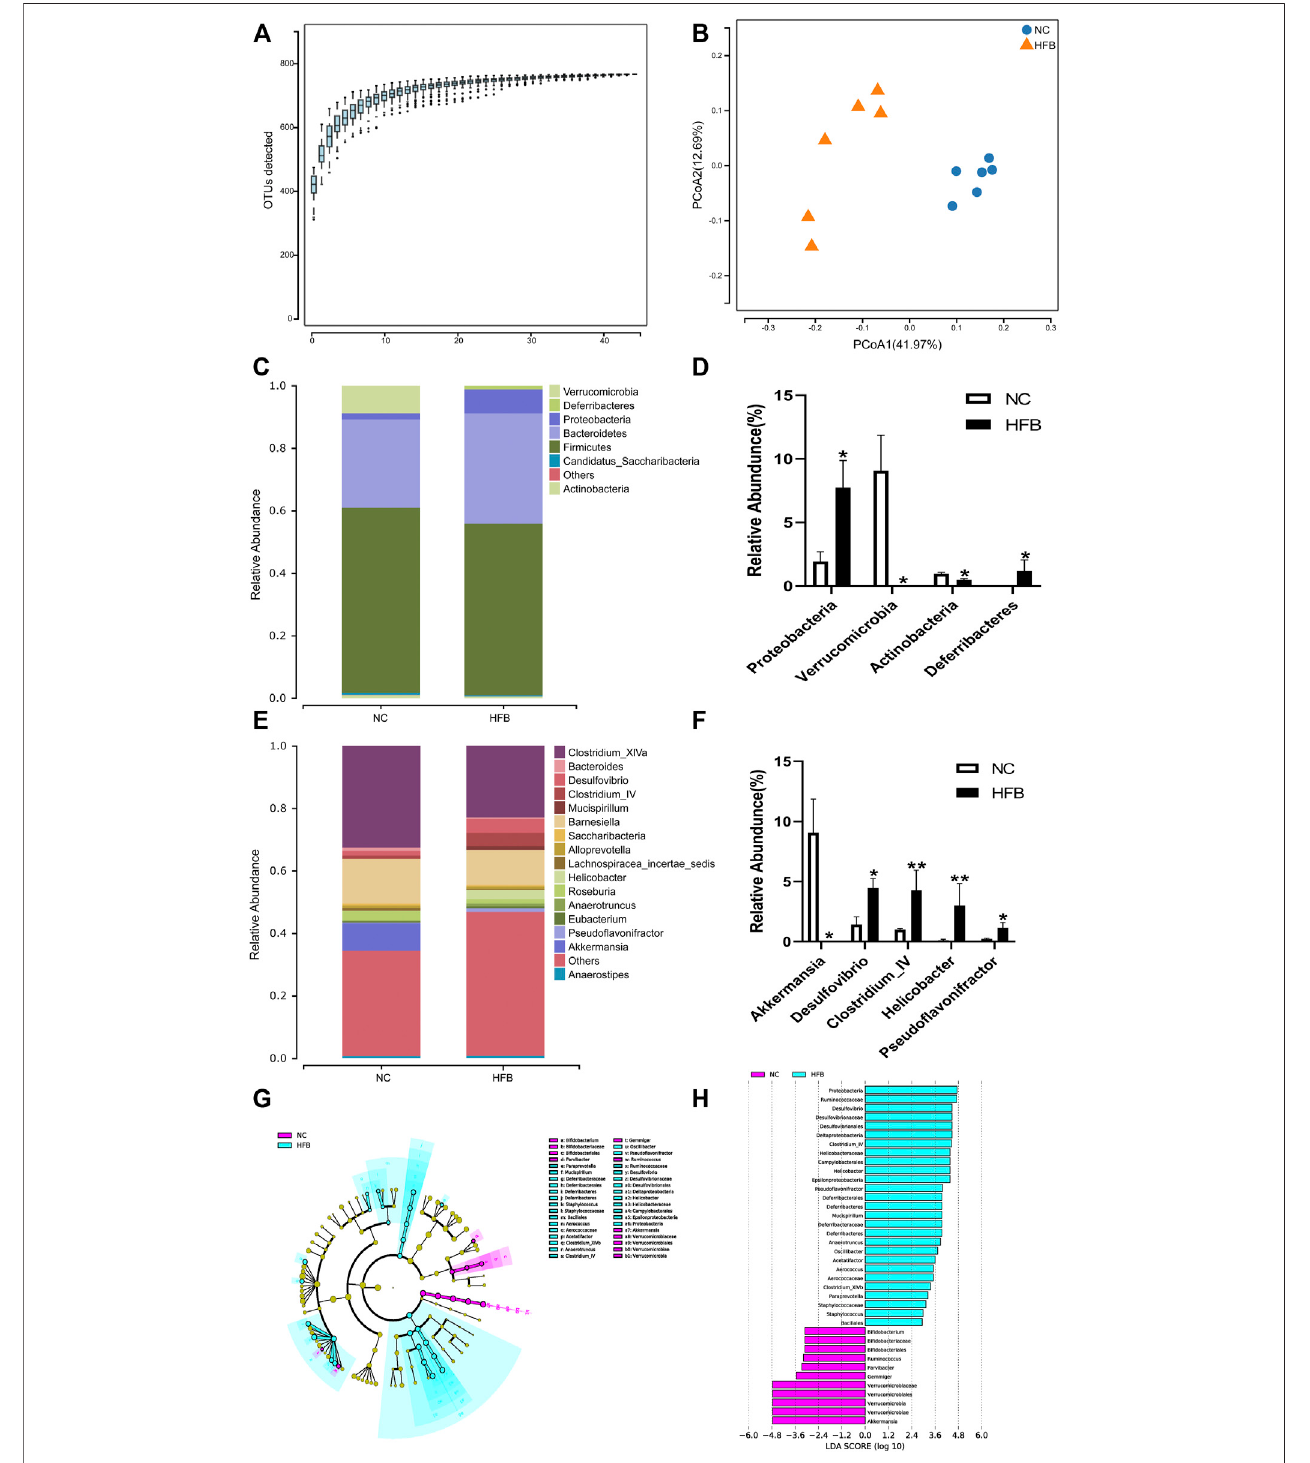
FIGURE 5 | Changes in intestinal fl ora in ApoE − / − mice fed continuous high-fat combined with bound stimulation. (A) Species accumulation graph. (B) PCoA plot. (C,E) Histograms ofspecies composition[ (C) phylum level; E :genus level]. (D,F) Statistical plots ofdifferential species (D) phylum level; (F) genus level),mean ± SEM,*, p < 0.05; **, p < 0.01; vs. NC. (G) LEfSe clustering diagram, with different colors indicating different groups, and different colored nodes indicating microbial groups that playanimportantroleinthegrouprepresentedbythecolor,onecolorcirclerepresentingabiomarker,andyellownodesindicatingmicrobialgroupsthatdonotplay an important role in the different groups. (H) LEfSe LDA